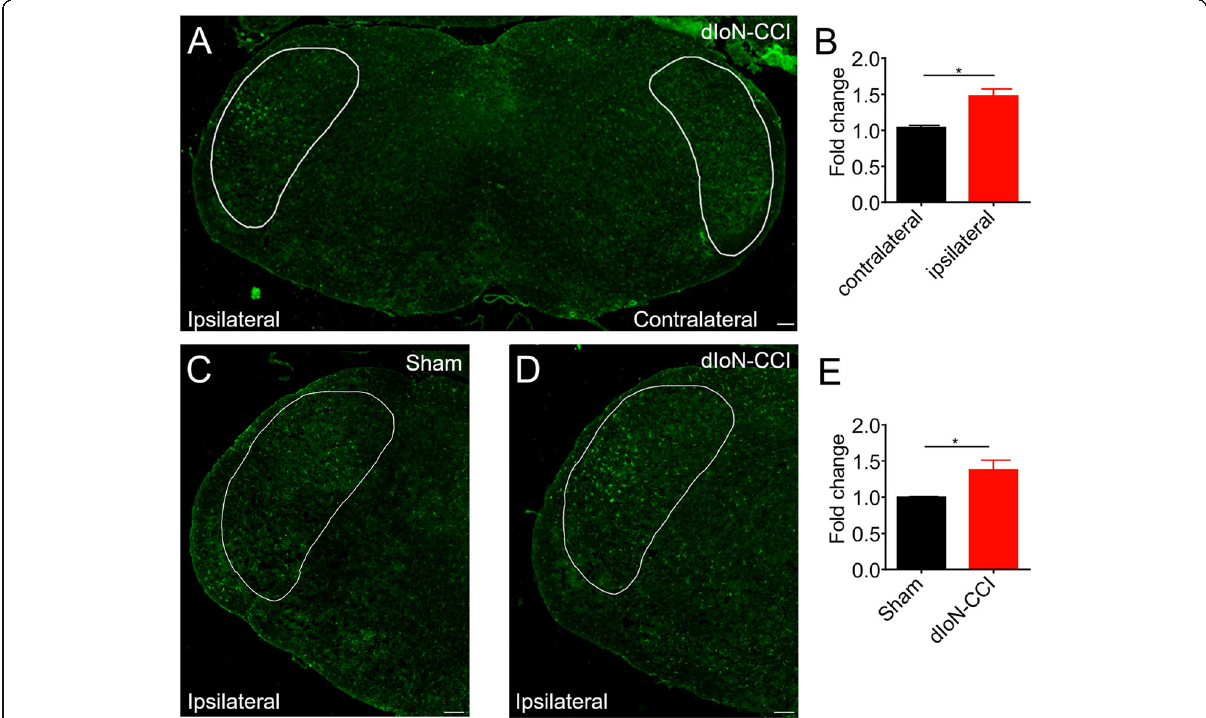
Fig. 7 Immunostaining analysis showed the protein expression of IBA-1 in the TNC site (the area circled by the white solid circle). a Upregulation of IBA-1 expression in the ipsilateral TNC induced by dIoN-CCI surgery in mice. b Quantitative analysis of IBA-1 immunofluorescence intensity in the ipsilateral and contralateral TNC site in the dIoN-CCI group, as fold of contralateral side to surgery. c Expression of IBA-1 in the ipsilateral TNC in the sham mice. d Upregulation of IBA-1 expression in the ipsilateral TNC in the dIoN-CCI surgery mice. e Quantitative analysis of IBA-1 immunofluorescence intensity in the ipsilateral TNC between sham and dIoN-CCI group. Data was expressed as Mean ± SEM. ( n = 3 each group, scale bar = 100 μ m, * P < 0.05 compared with the control, unpaired Student ’ s t-test) TNC, trigeminal nucleus caudalis; dIoN-CCI,